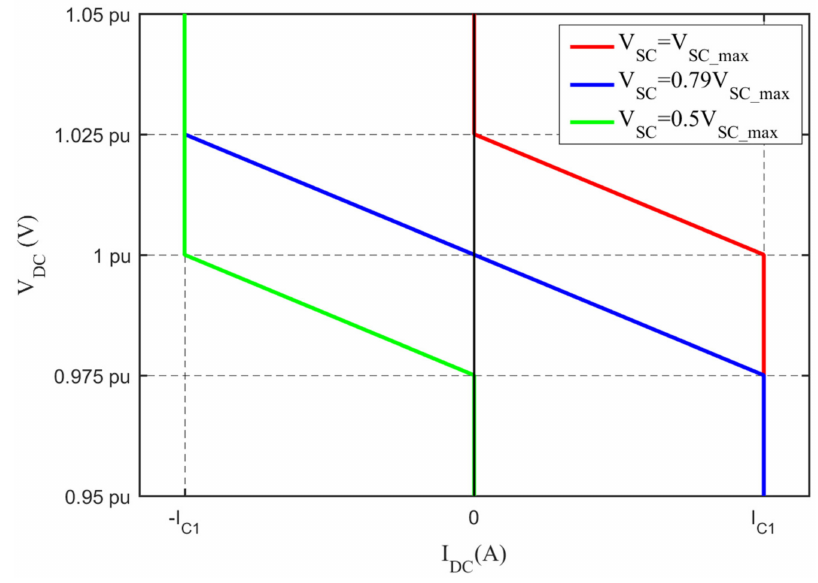
Figure 6. The dribbling supercapacitor I vs. V